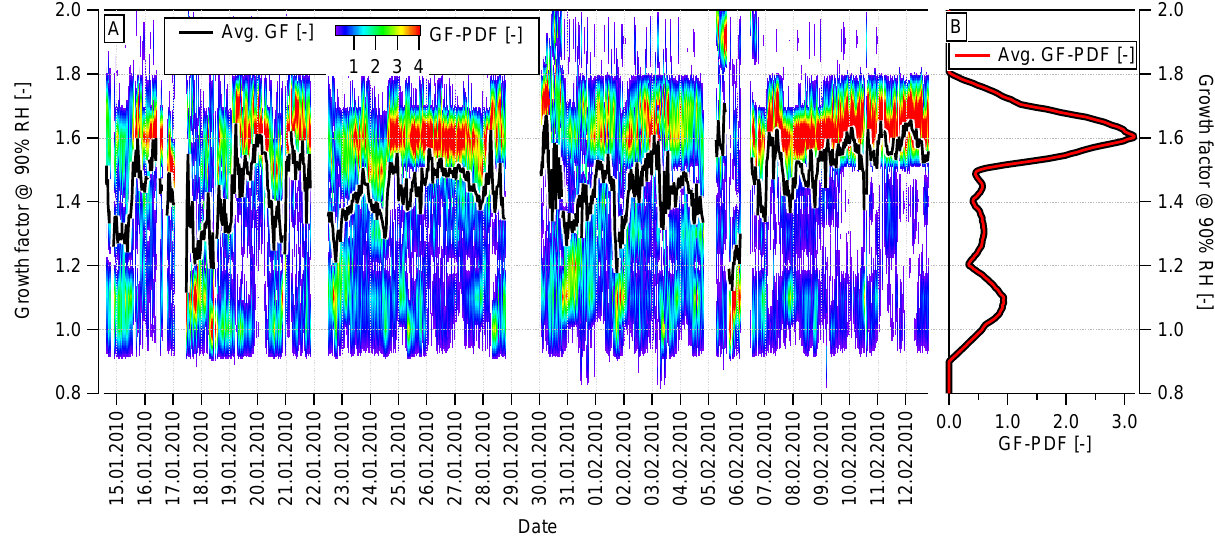
Fig. 7. (A) Growth factor probability distribution function (GF-PDF; contour plot) and average growth factor (black line) as measured by the HTDMA, at 90%RH and for particles with a dry mobility diameter of D 0 265nm dry mobility diameter. (B) GF-PDF averaged over the entire measurement